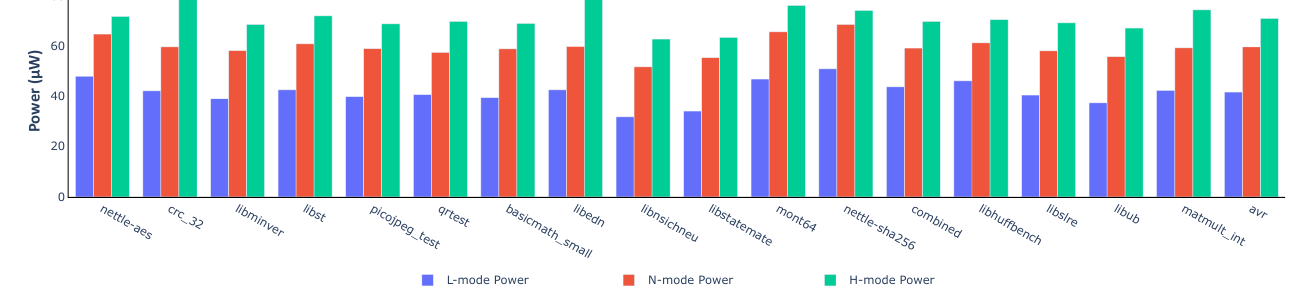
Figure 11. Power consumption of the variable processor in different modes. As shown in Figure 12, the average power of different modes are 41.7 µ W, 59.7 µ W and 71.1 µ W, respectively. Typically, N-mode and L-mode consume 16.08% and 41.37% less power than H-mode within the same clock period. The power consumption of each mode increases a little over the value that is in the corresponding baseline core. This is caused by two reasons: (1) The execution controller in the variable core is a little more complicated than those of TinyCore and LittleCore. Thus, the power of the “logic” part increases a little. (2) Many NAND cells are inserted after some of the pipeline registers, leading to the power increasing in the “PipeReg” part.